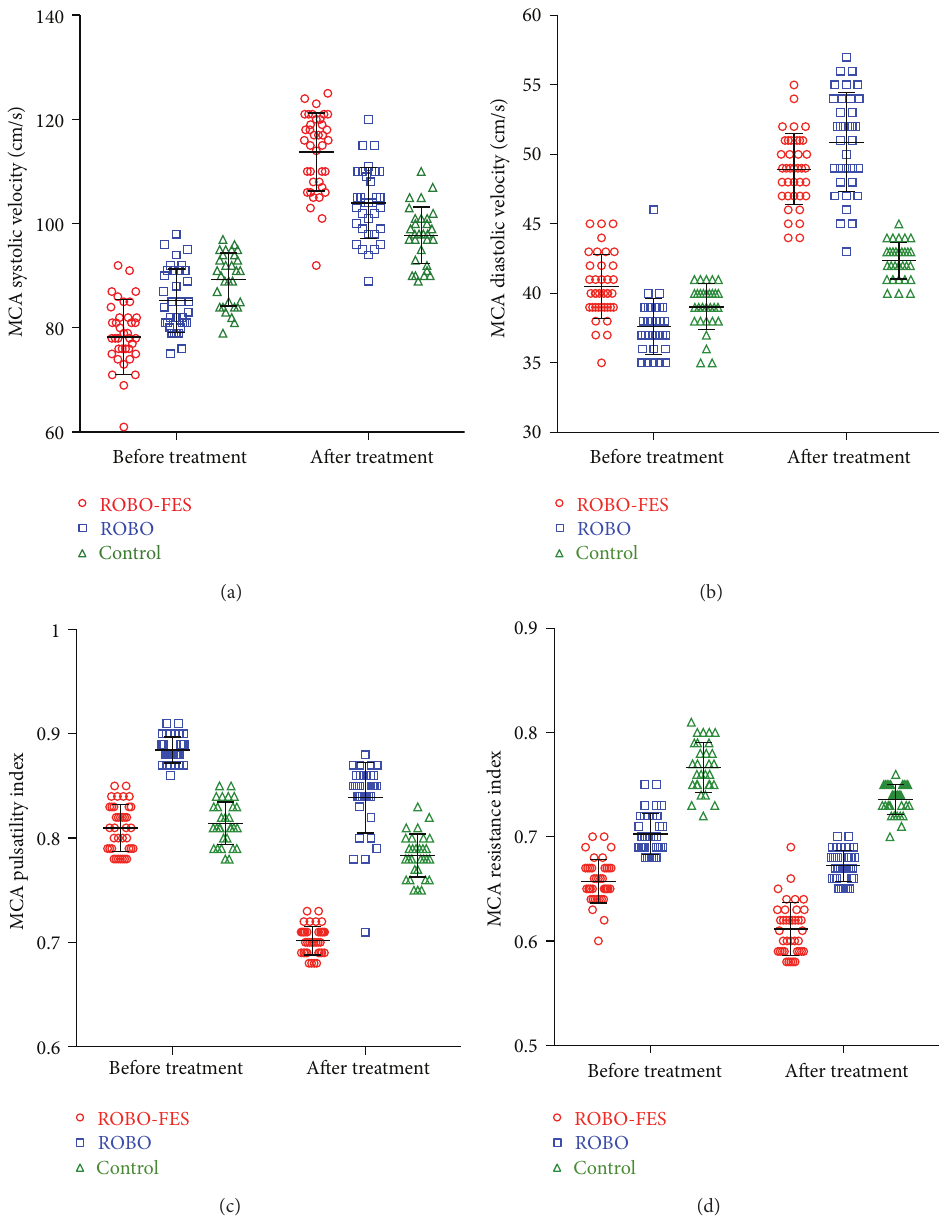
Figure 4: Changes in cerebral blood flow parameters over the course of treatment. (a) and (b) Systolic and diastolic blood flow velocity in the middle cerebral artery (MCA) of the affected hemisphere increased in robotic groups more than in control. (c) and (d) Indices of pulsatility and vascular resistance were mainly improved by ROBO-FES, while ROBO training had similar effects as compared with control. Error bars indicate standard